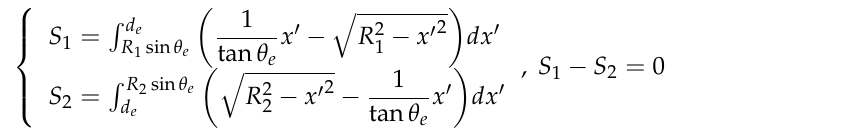
Figure 8. Electrode of flat-electrode HRG: ( a ) Top view of electrode base; and, ( b ) Enlarged view of part Valid Electrode Zone.